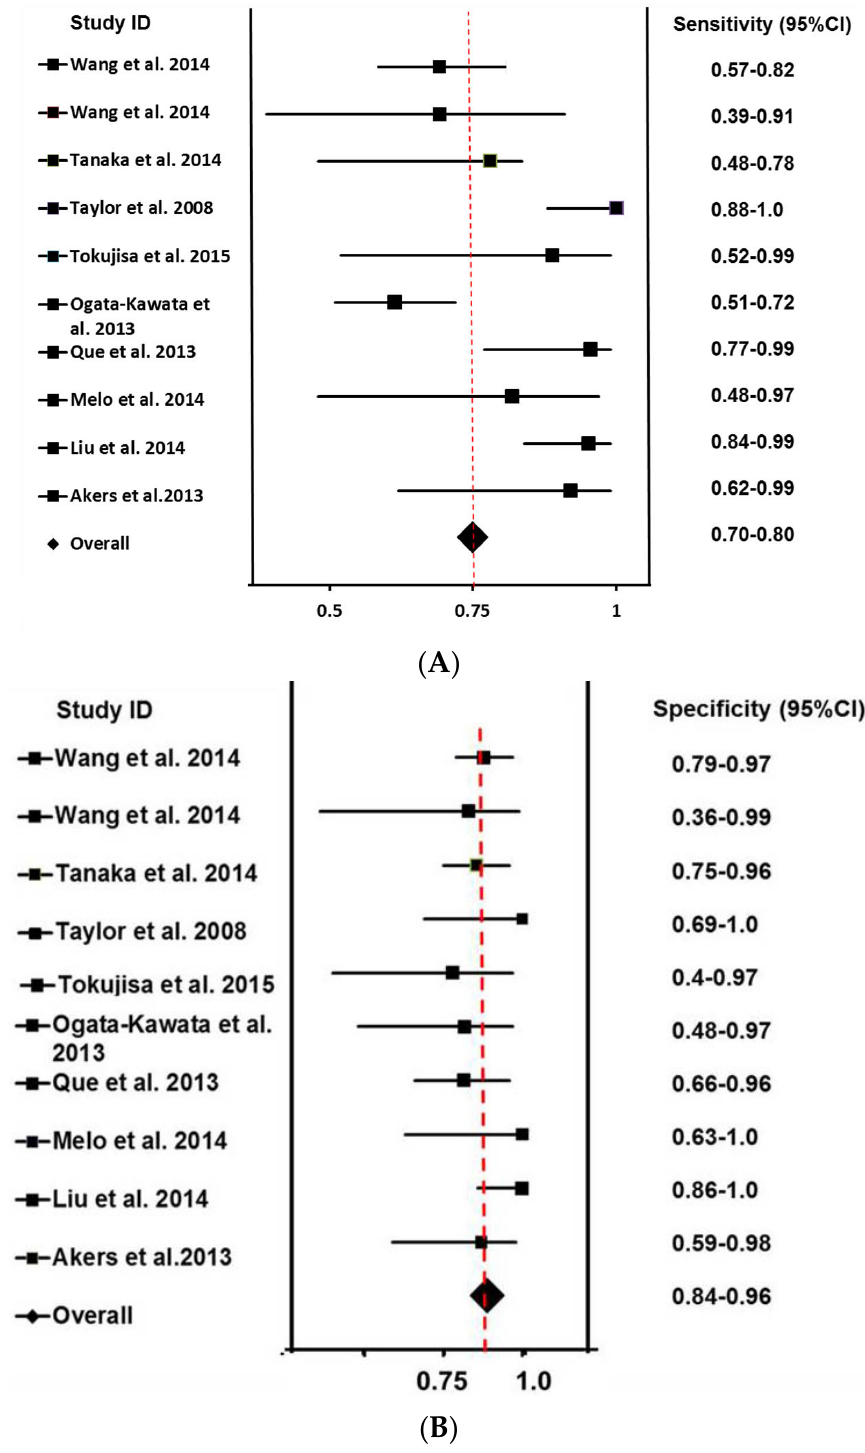
Figure 2. The forest plots of sensitivity ( A ) and specificity ( B ) of each included studies. In each picture, the left side shows the ID of studies, and the right side shows their 95% CIs.